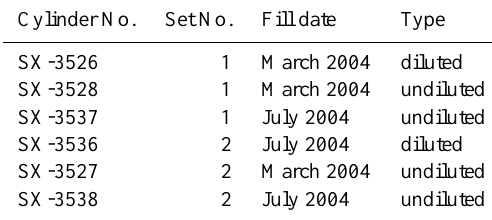
Table 2. Air samples distributed to labs. Cylinder